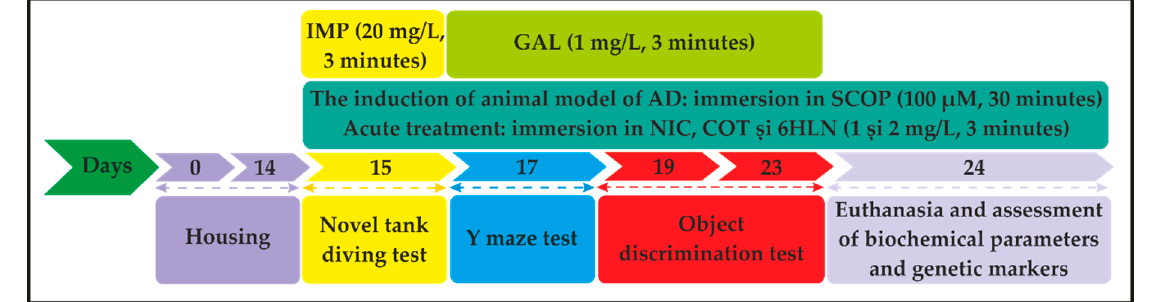
Figure 2. The timeline and experimental design of the study (IMP ‐ imipramine; GAL ‐ galantamine; AD ‐ Alzheimer’s disease; SCOP ‐ scopolamine; NIC ‐ nicotine; COT ‐ cotinine; 6HLN ‐ 6 ‐ hydroxy ‐ L ‐ nicotine).